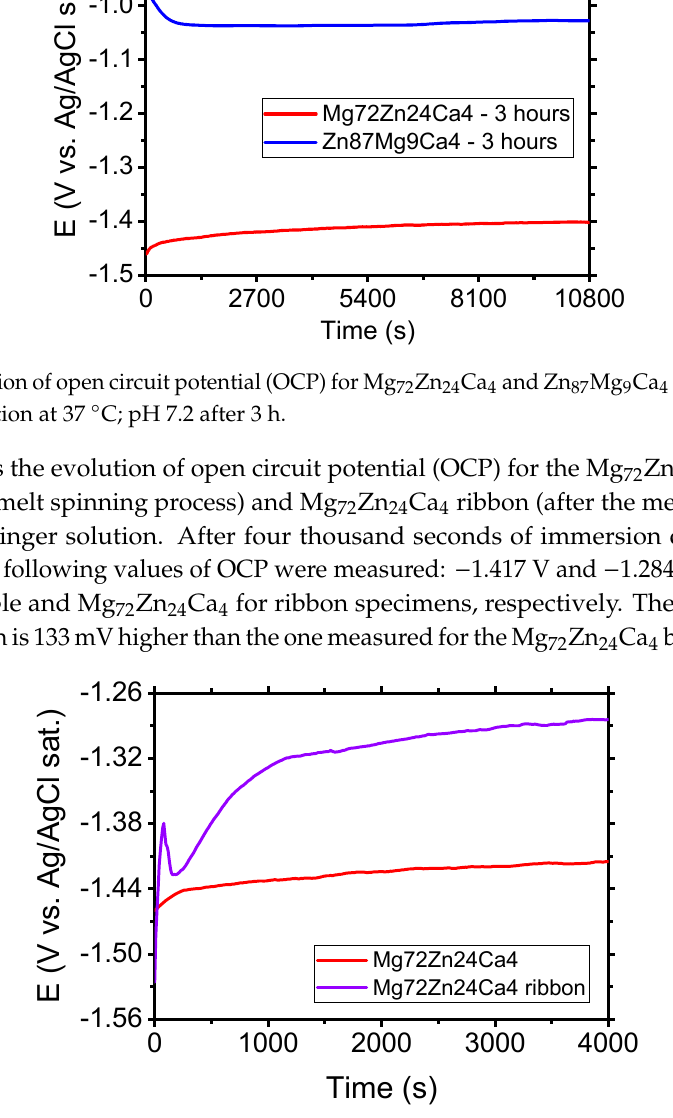
Figure 7. Evolution of OCP for Mg 72 Zn 24 Ca 4 bulk material and Mg 72 Zn 24 Ca 4 ribbon specimens in Ringer’s solution at 37 ° C; pH 7.2 after four thousand seconds.